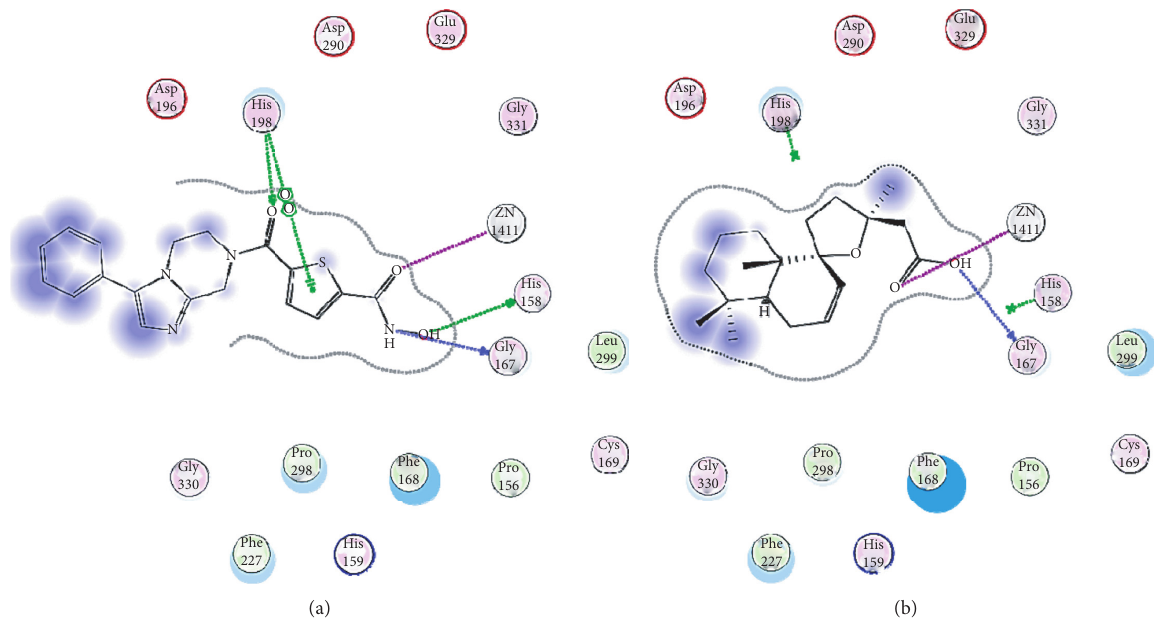
Figure 4: (a) 2D structure of the co-crystallized ligand docked into the active site of HDAC. (b) 2D structure of compound 1 docked into the active site of HDAC.